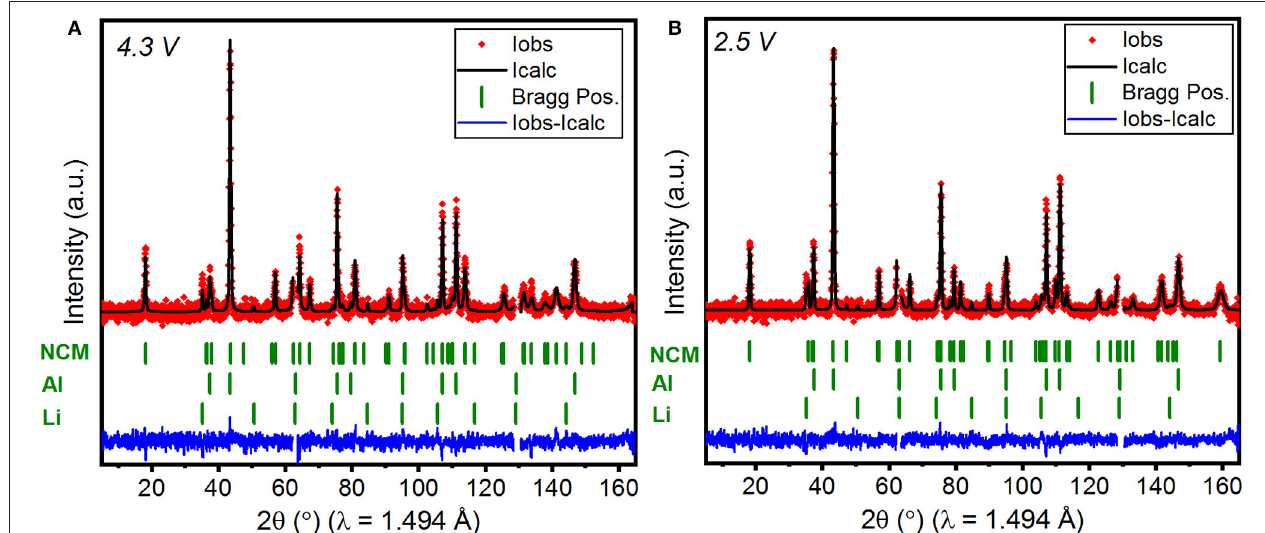
The corresponding Rietveld refinement profiles are presented Figure 8. The refined structural parameters are summarized in Table 2 and compared to the structural parameters obtained from the Rietveld refinements on neutron diffraction data collected in operando and for the pristine powder. The results of refinements from the datasets collected in the cell, at constant voltage (CV), and in operando (O), were in fact obtained on the background- corrected data: the contributions from the Celgard separator and from the deuterated electrolyte were subtracted prior